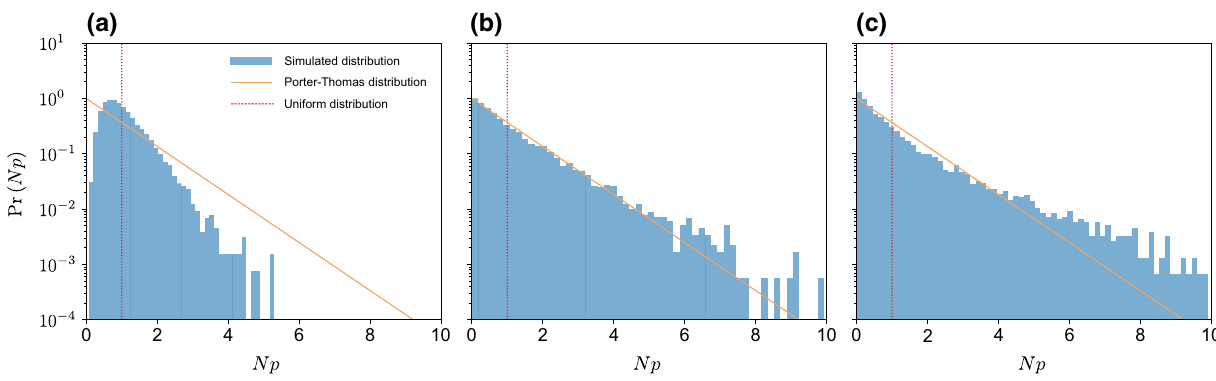
FIG. 11. The output probability distribution for sampling of a random MPS. We plot the rescaled probability distributions obtained from sampling Haar-random MPSs, varying the bond dimension and number of qubits sampled. Once again, the orange line represents the ideal Porter-Thomas distribution Pr ( Np ) = e − Np and the red dashed line is the uniform distribution δ( p − 1 / N ) . Qualitatively, these distributions follow the same transition seen in the simulation of Haar-random unitary evolution and random Hamiltonian evolution for varying sampling times. (a) Sampling on seven qubits of a 12-qubit Haar-random MPS with maximum bond dimension χ = 64. (b) Sampling on all 12 qubits of a 12-qubit Haar-random MPS with maximum bond dimension χ = 64. (c) Sampling on all 12 qubits of a 12-qubit Haar-random MPS with nonmaximal bond dimension χ =